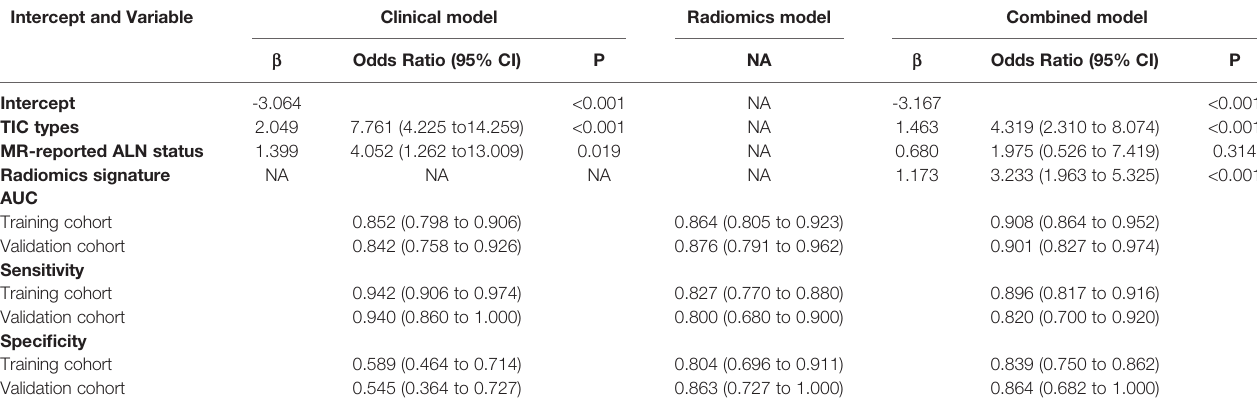
TABLE 3 | Risk factors for malignancy and the performance of the clinical and combined models for breast non-mass enhanced (NME) lesions. Intercept and Variable